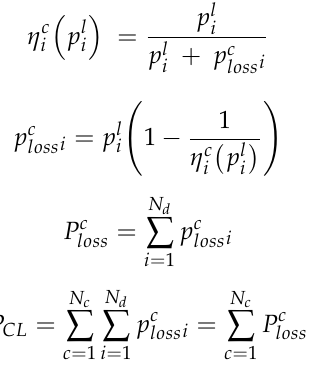
Figure 3. House floor plan and wiring diagram.